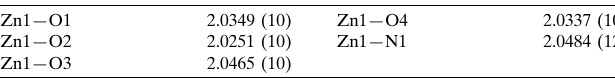
Selected bond lengths (A˚ ).